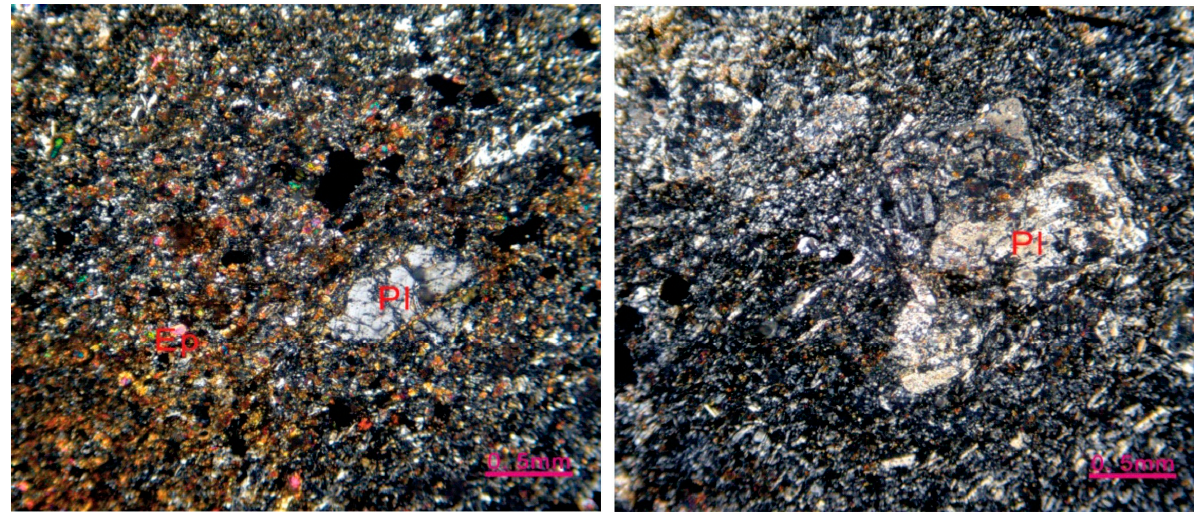
Figure 2. Micrographs of mafic volcanic rocks in the Badaguan area: Pl, plagioclase; Ep, epidote.